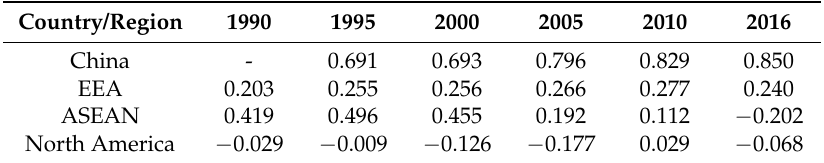
Table 2. Competition index in textile materials of China, EEA, ASEAN and North America in UK market (competition index = (X i − M i )/(X i + M i ), Xi means country i exports to the UK, M i means country i imports from the UK).